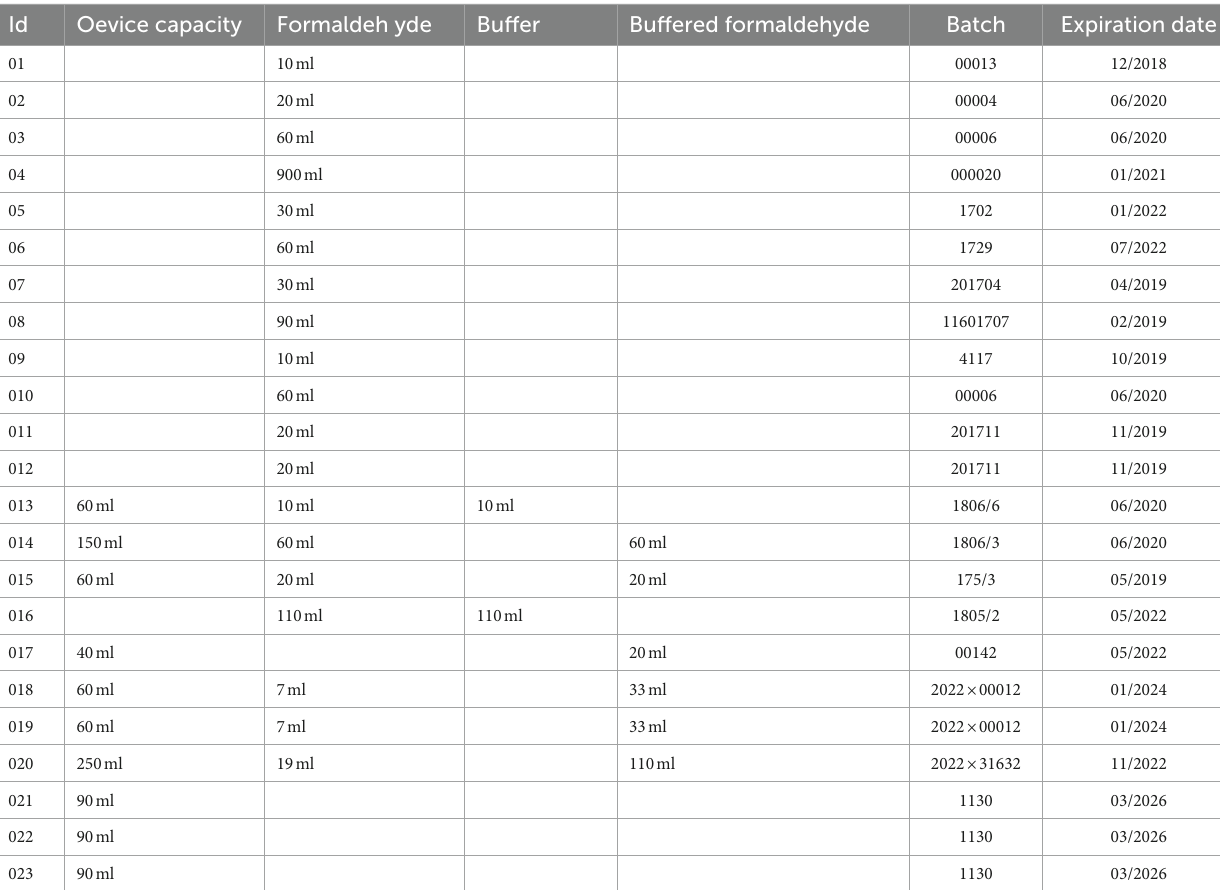
TABLE 2 Characteristics of the